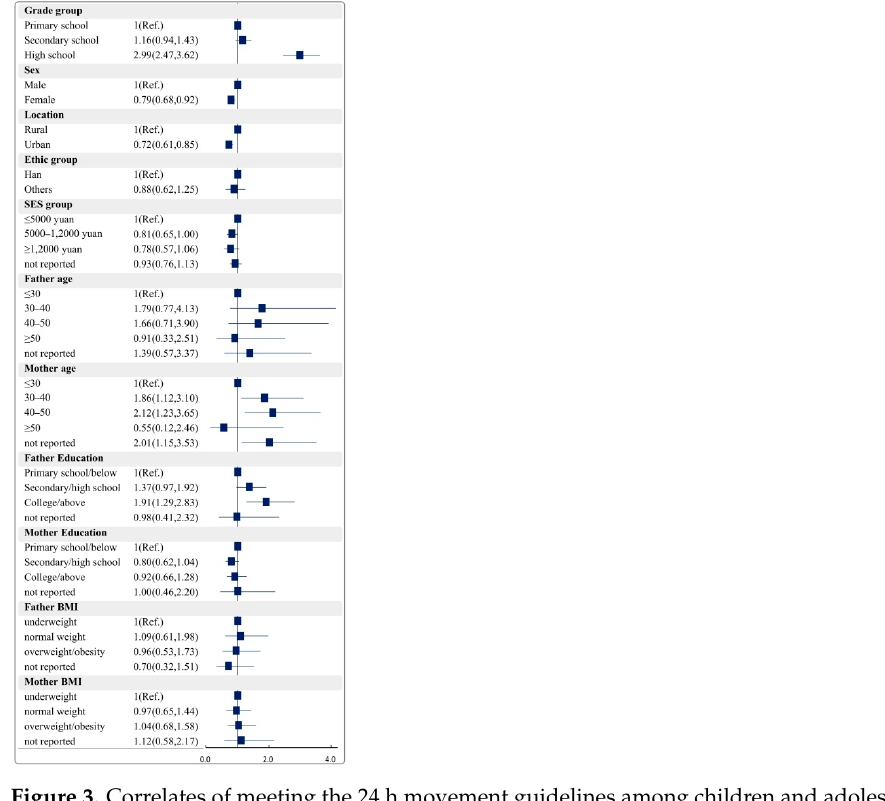
Figure 3. Correlates of meeting the 24 h movement guidelines among children and adolescents. BMI: body mass index; SES: social economic status; OR: odds ratio; 95%CI: 95%confidence interval.